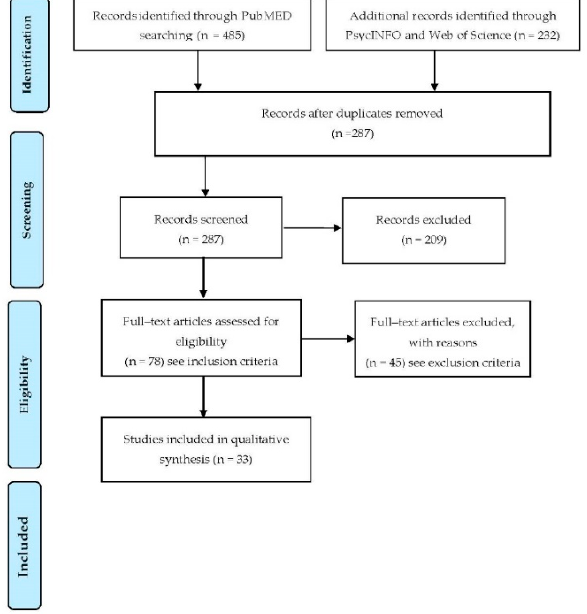
Figure 1. Preferred Reported Items for Systematic Reviews and Meta–analyses (PRISMA) chart summarizing the selection process.